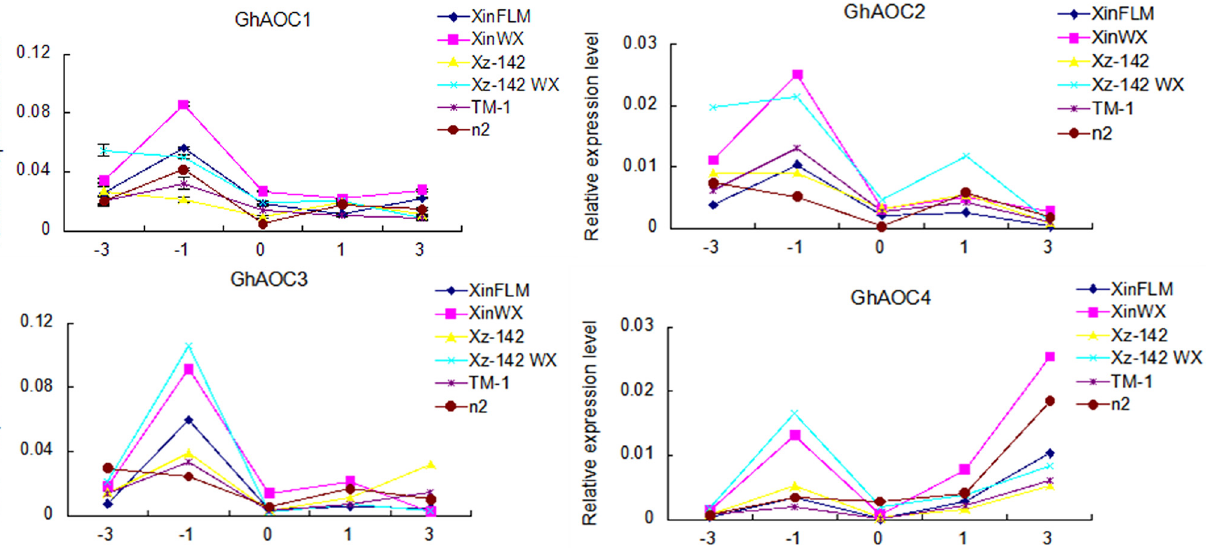
Fig 6. Relative expression of AOCs in fiber mutant lines during the early stages of fiber development. Mixtures of ovules and fibers at -3, -1, 0, 1 and 3 DPA are shown in x-axis. Error bars indicate ± SD of triplicate experiments. Three biological replicates were used for calculation.